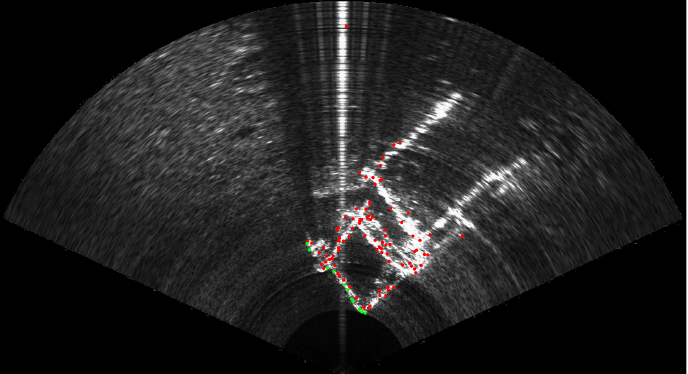
Figure 8. Selection process of the sonar feature points. Similarly to Figure 7, green points are the remaining points p s after the suppression of the red points located further than ρ max range or i occluded by a closer point located on the same acoustic